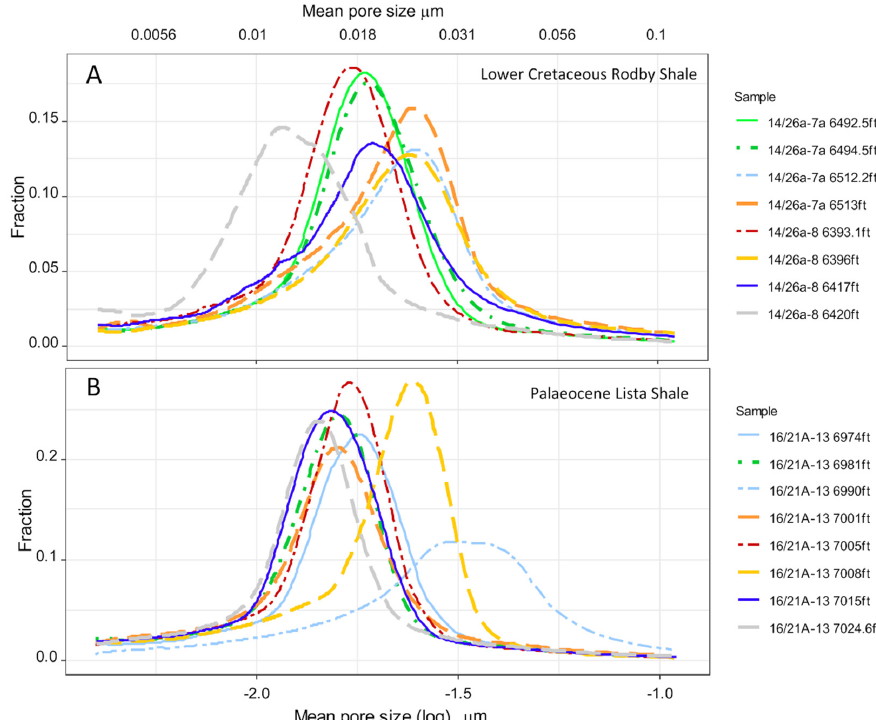
Figure 8. Comparison of the pore size distributions, from mercury intrusion porosimetry, from eight samples each in the Lower Cretaceous Rodby Shale and the finest grained parts of the Palaeocene Lista Formation. ( A ) Lower Cretaceous Rodby Shale pore size distribution data with an overall mean value of approximately 18 nm but with sample mean values ranging from 11 to 25 nm. ( B ) Palaeocene Lista Shale pore size distribution data with an overall mean value of approximately 18 nm but with sample mean values ranging from 14 nm to approximately 31 nm. The Rodby and Lista Shales are not hugely different in terms of pore throat sizes; if anything, the Rodby has slightly smaller pore throats than the Lista, at least as represented by these 16 samples.